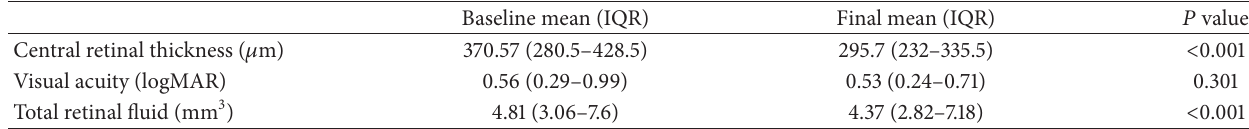
Table 3: Whole group anatomical and visual measurements following aflibercept.